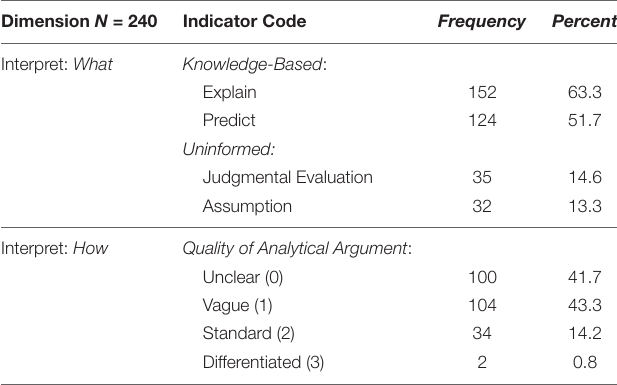
TABLE 5 | Overall frequencies of interpreting PV skill content